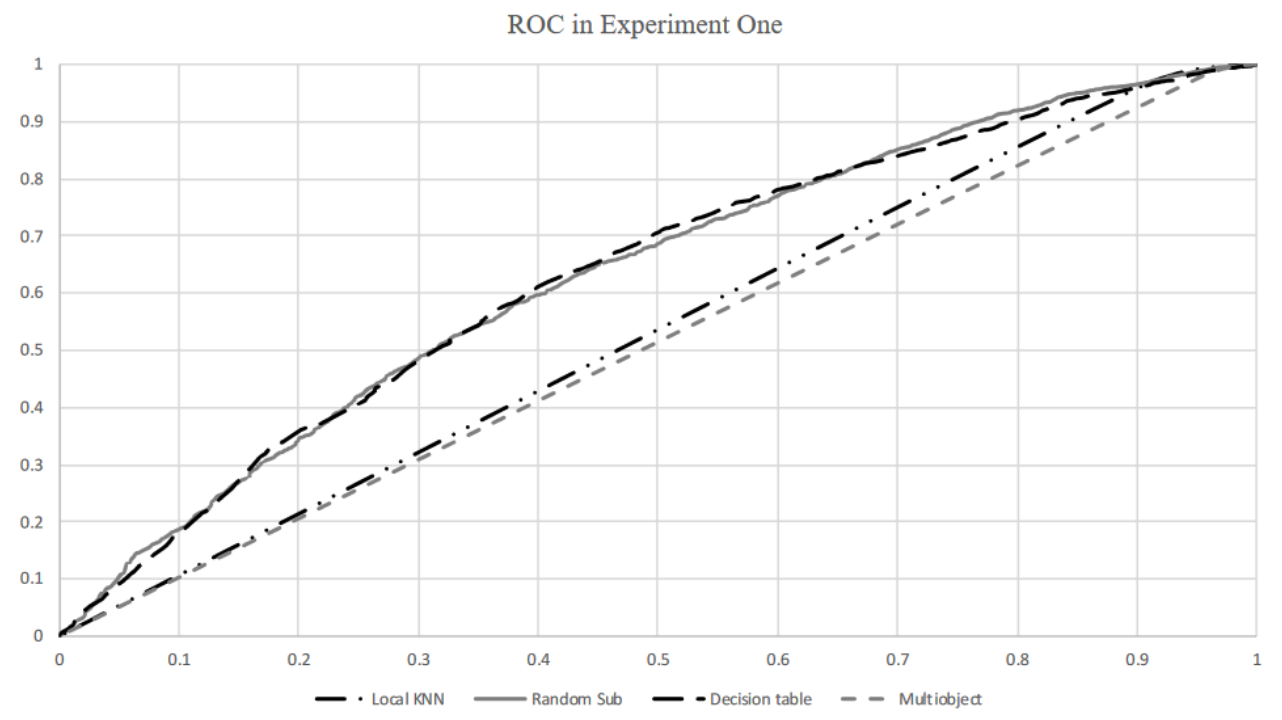
Figure 1. Receiver operating characteristic (ROC) curves for local KNN, random subspace, decision table, and multiobject algorithms.